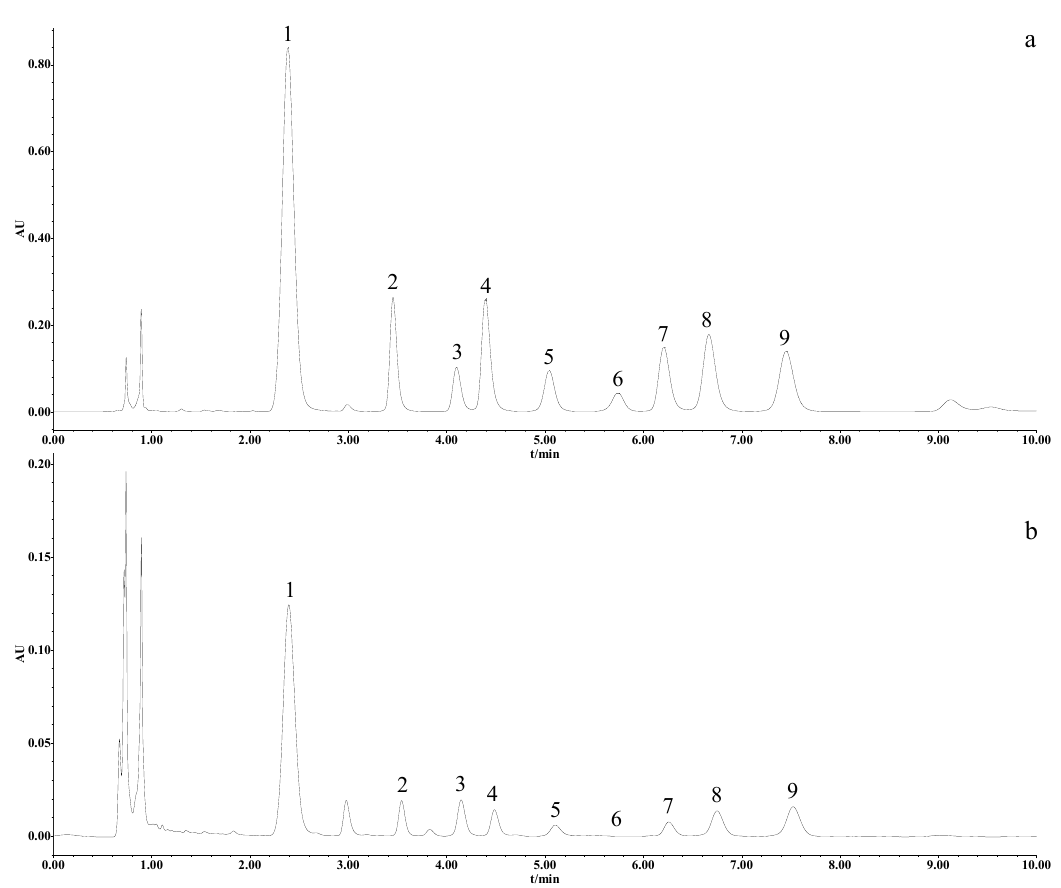
Figure 3. Chromatograms of the eight monosaccharides in ( a ) the mixed standard and ( b ) gauze slices of freeze-dried velvet antler. Peak numbers 1–9 represent 1-phenyl-3-methyl-5-pyrazolone, mannose, glucosamine, ribose, glucuronic acid, galacturonic acid, aminogalactose, glucose, and galactose, respectively.